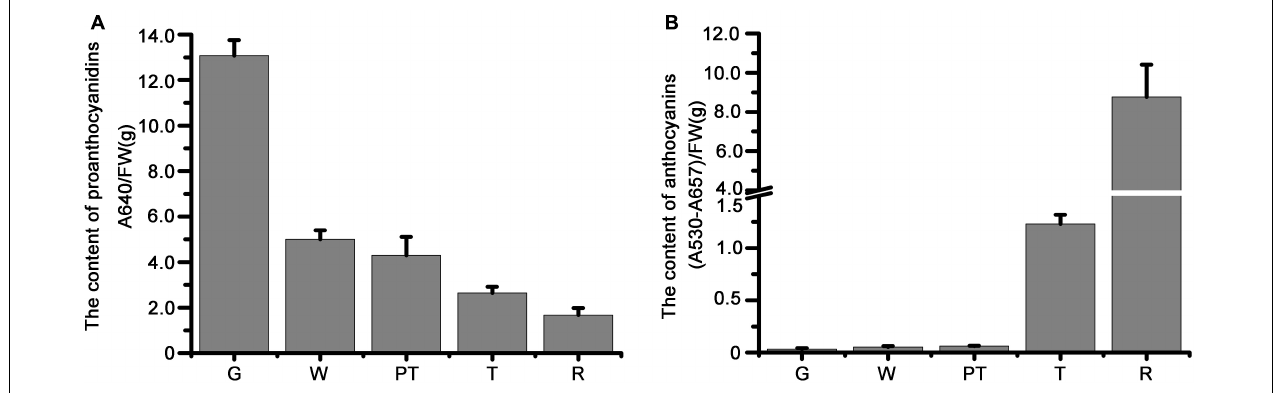
FIGURE 3 | The measurement of anthocyanins and proanthocyanidins in fruits of different development stages. (A) Proanthocyanidins; (B) anthocyanins. G, green stage; W, white stage; PT, pre-turning stage; T, turning stage; R, ripe